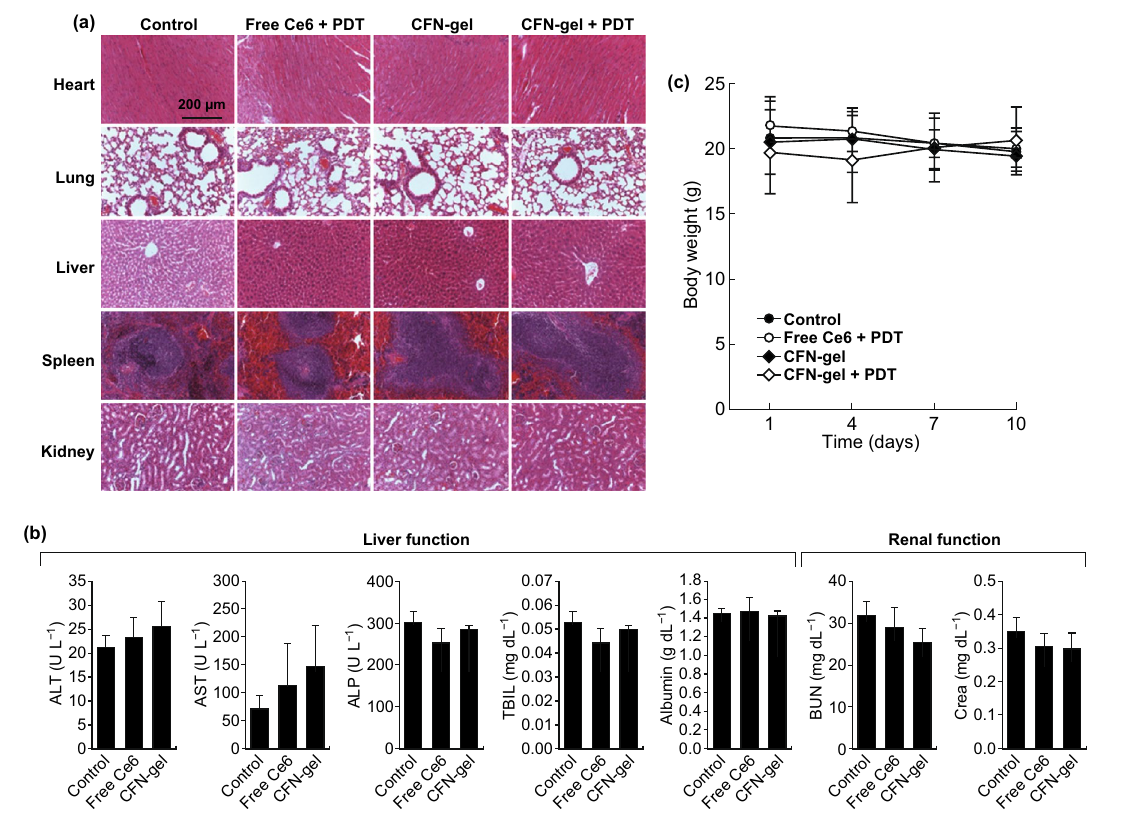
Fig. 8 In vivo biocompatibility of CFN‑gel. a Representative H&E‑stained images of major organs collected from different treatment groups on day 10, b blood chemistry data of mice in the PBS‑, free Ce6‑ and CFN‑gel‑treated groups on day 10 ( n = 4), c change in average body weight of mice in different groups over time. No apparent signs of toxicity in organs, blood biomarkers and body weights were observed in any treatment